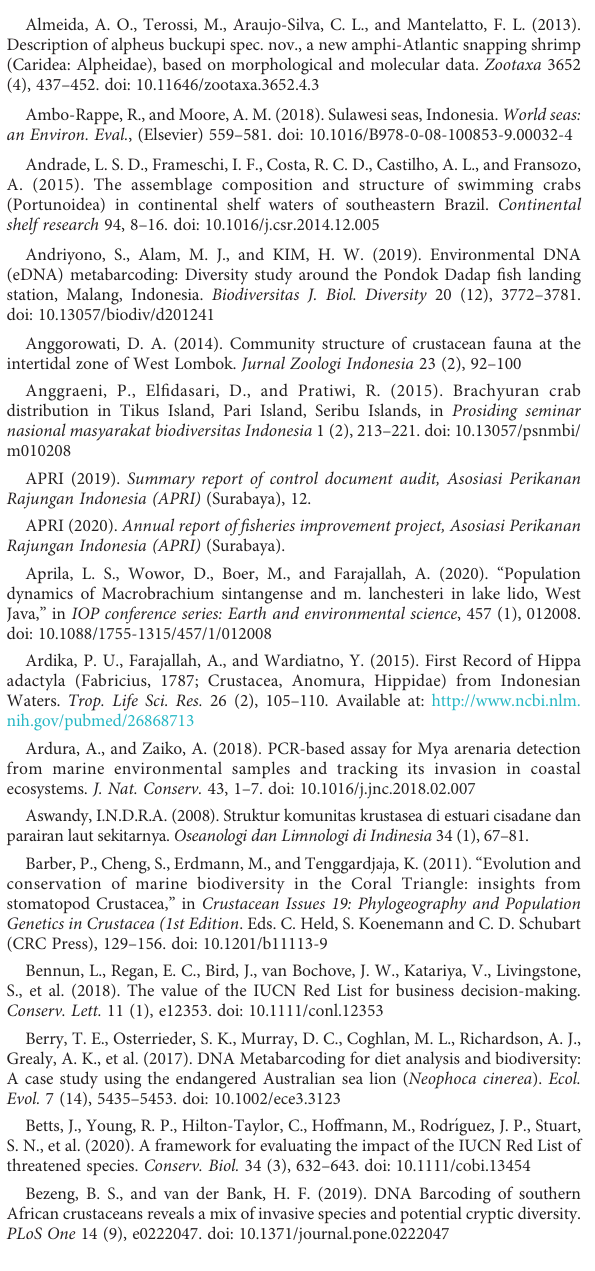
SUPPLEMENTARY FIGURE 1 Overview of mBRAVE Project Analytical Parameter settings used for this study. The 4 steps with analytical parameters included trimming, fi ltering, clustering, and paired end merging of project MBR-WCRMIDECA. SUPPLEMENTARY FIGURE 2 Decapod species accumulation curve based on species richness from eDNA samples collected from coral reefs across